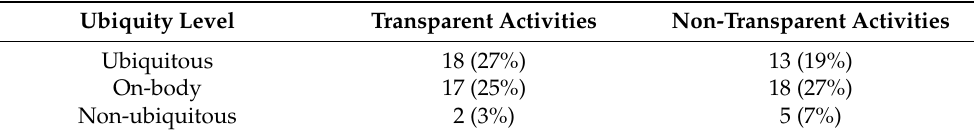
Table 3. Number of studies describing devices working in transparent (middle column) and non- transparent (right column) activities for each type of ubiquity level. The figures in brackets represent the percentage of studies compared to the total number of